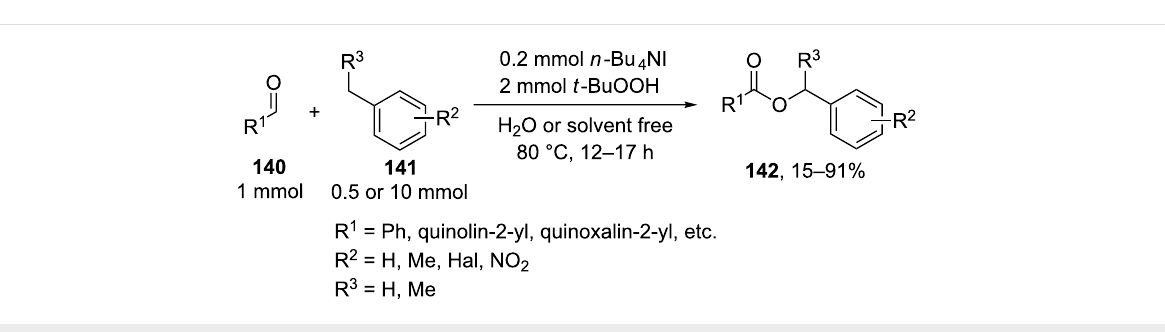
Scheme 28: Oxidative coupling of methyl- and ethylarenes with aromatic aldehydes under the action of Bu 4 NI/ t- BuOOH system.